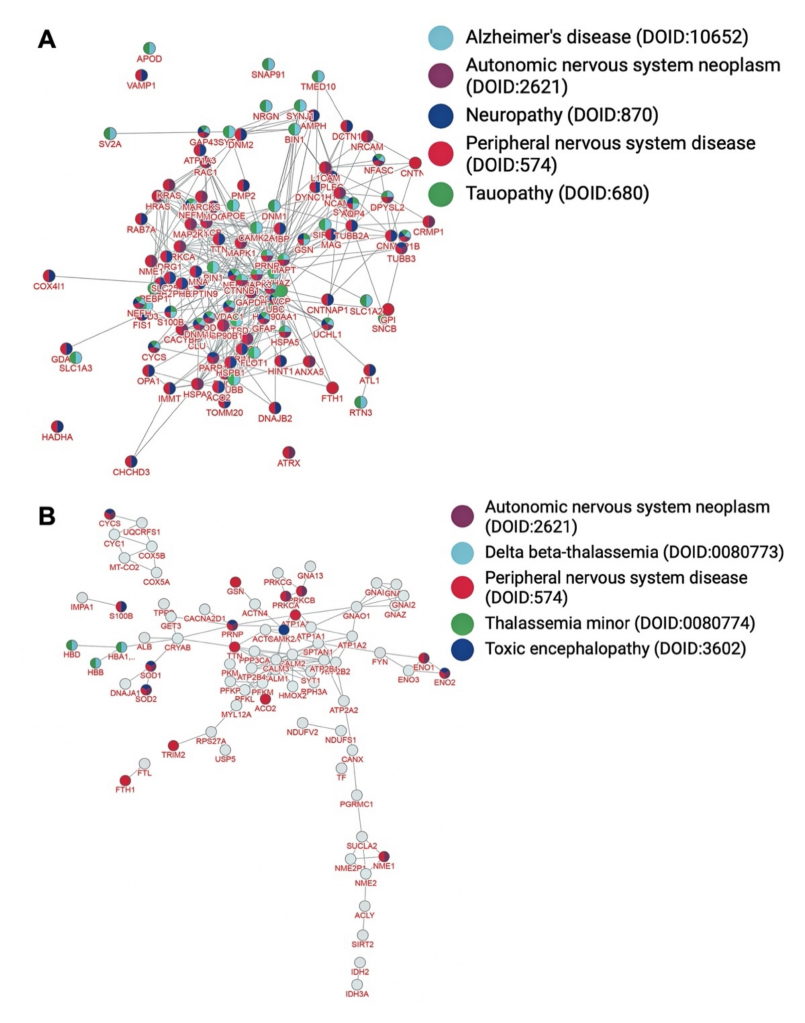
Figure 4. Enriched PPI network of myelin ( A ) and sub-PPI network of metalloproteome ( B ) based on associated diseases (diseasome or disease